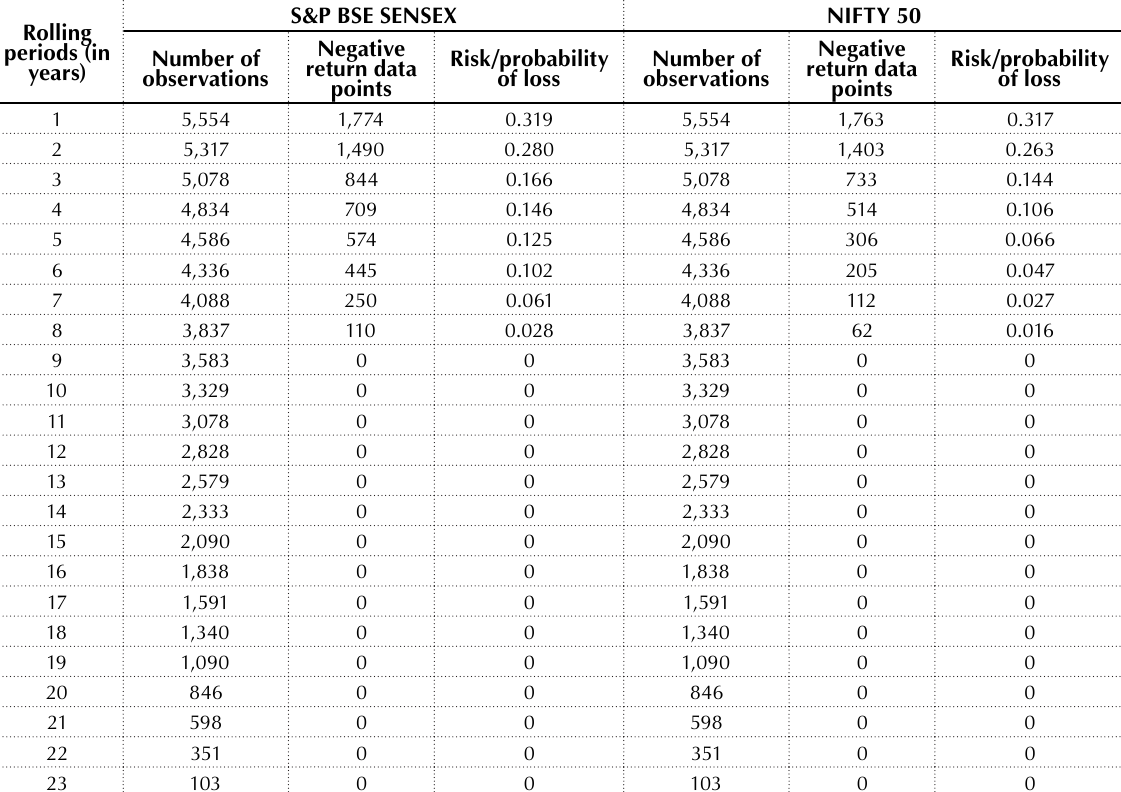
Table 11. Rolling period risk and return behavior of S&P BSE SENSEX and NIFTY (from 1995 to 2018)